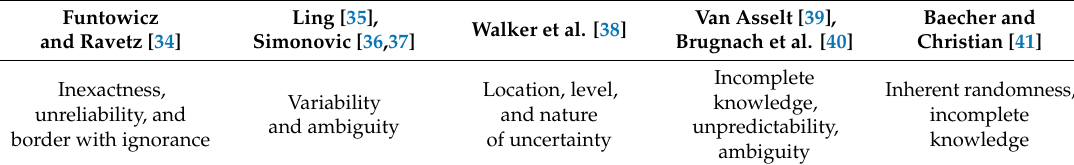
Table 1. Di ff erent approaches for characterization of Table 1. Different approaches for characterization of uncertainty.